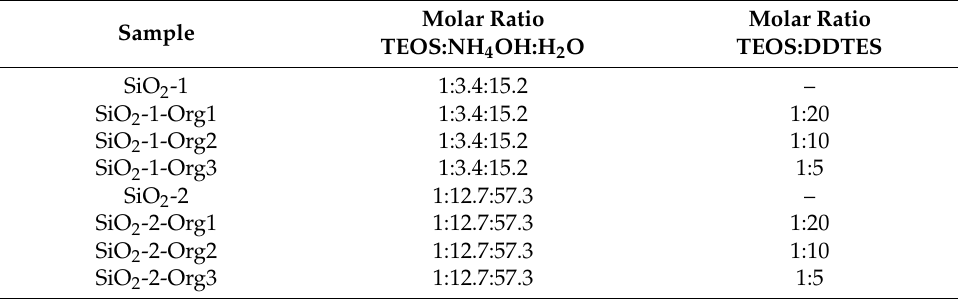
Table 1. Composition of silica-based nanocoatings.